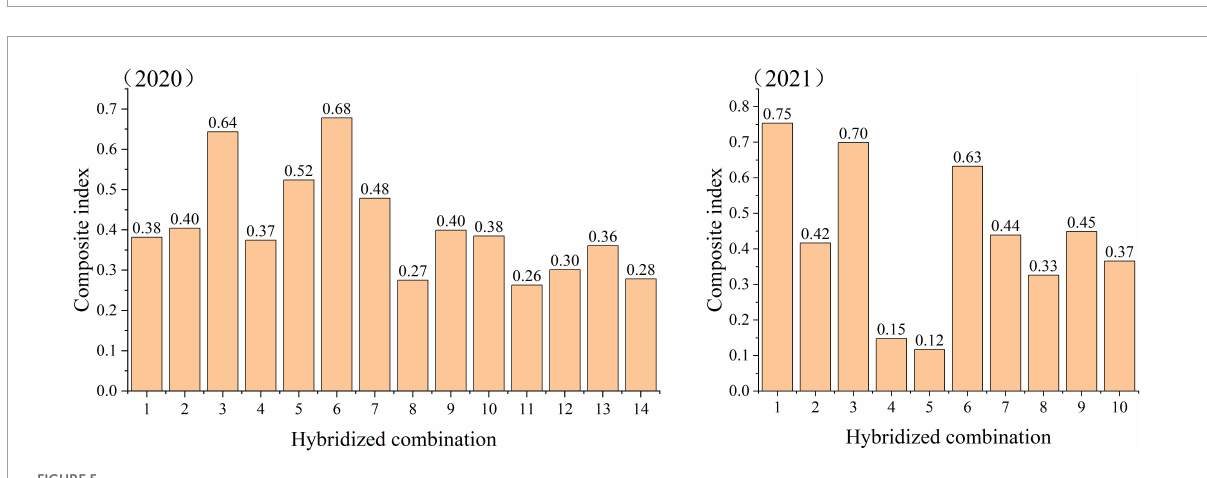
FIGURE5 The comprehensive index of fertility of the tested hybrid combinations in 2020–2021. The hybrid combination with Meili as the female parent hardly harvested full seeds in 2021, which may be related to the premature emasculation. In order not to affect the authenticity of the overall results, Combinations 11, 12, 13, and 14 were removed from the analysis in